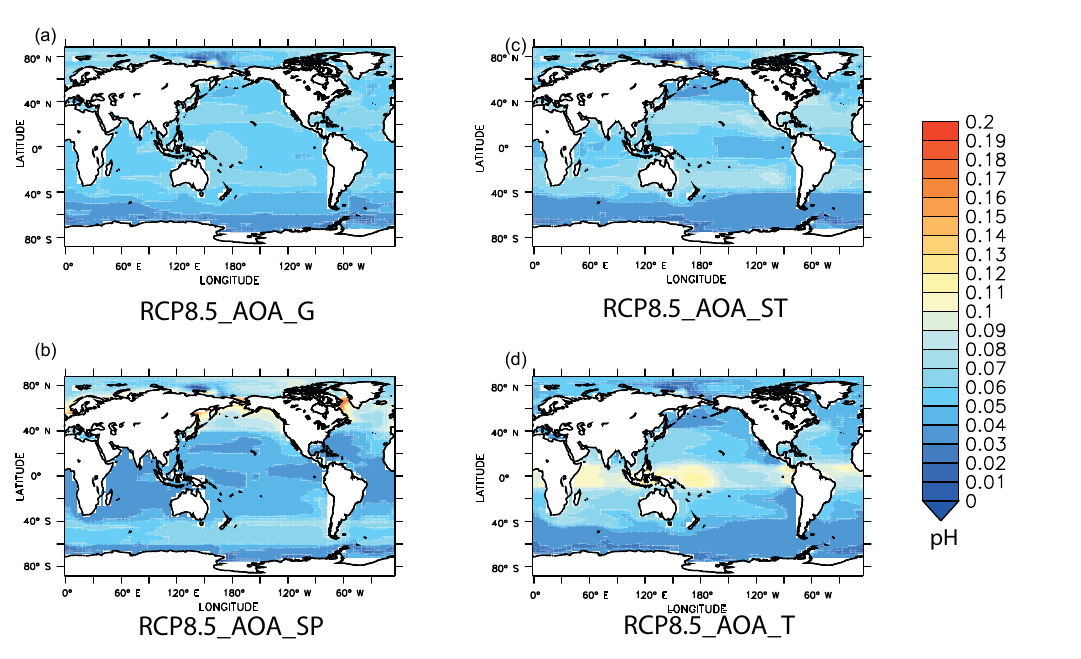
Figure 9. The spatial map of the changes in pH in 2090 (mean; 2081–2100) associated with global and regional AOA under RCP8.5, relative to RCP8.5 with no